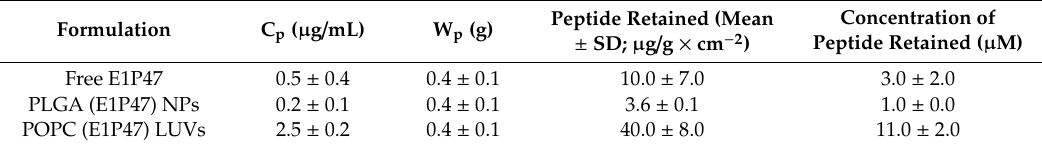
Table 4. Values of the concentration of peptide extracted from the mucosa (C p ), weight of the mucosa (WP) and quantity of peptide retained in the ex vivo permeation study. Values express the mean and standard deviation of two independent